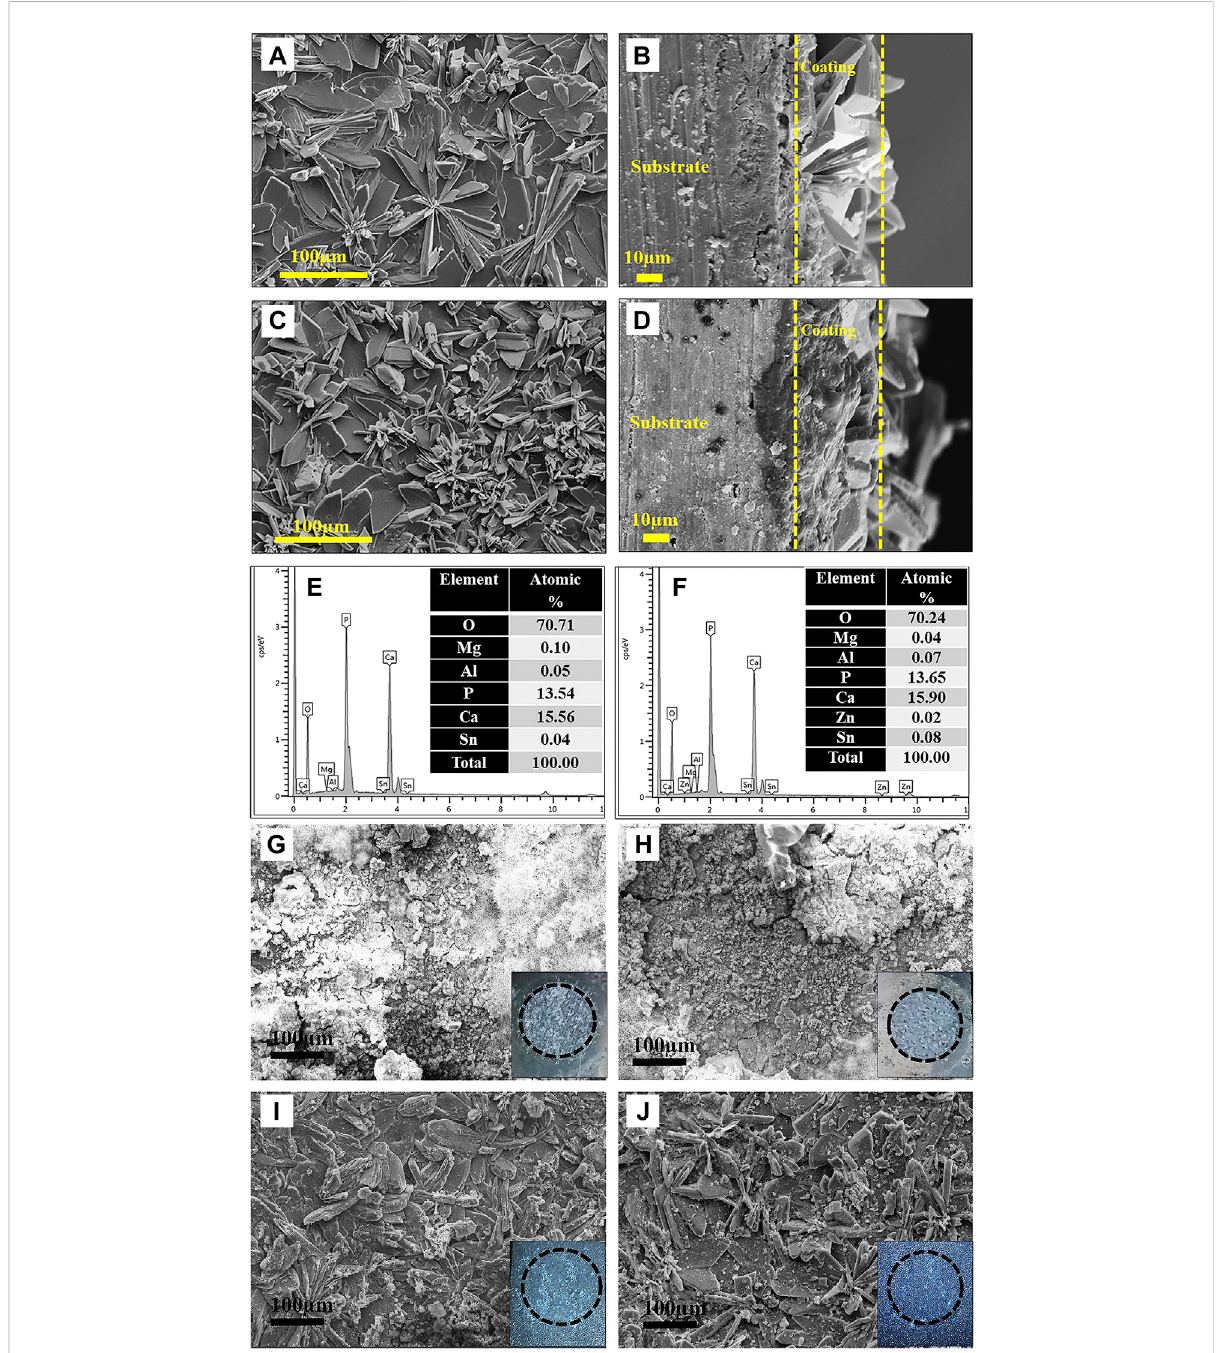
FIGURE 2 SEMimages: (A,C) PCCcoatedsurfaceand (B,D) cross-sectionofLAT971andLATZ9531;EDSspectrum: (E) LAT971and (F) LATZ9531alloy;SEM images after corrosion test: (G,H) uncoated and (I,J) PCC coated LAT971 and LAT9531, respectively. Reprinted with permission from reference (Maurya et al., 2018),